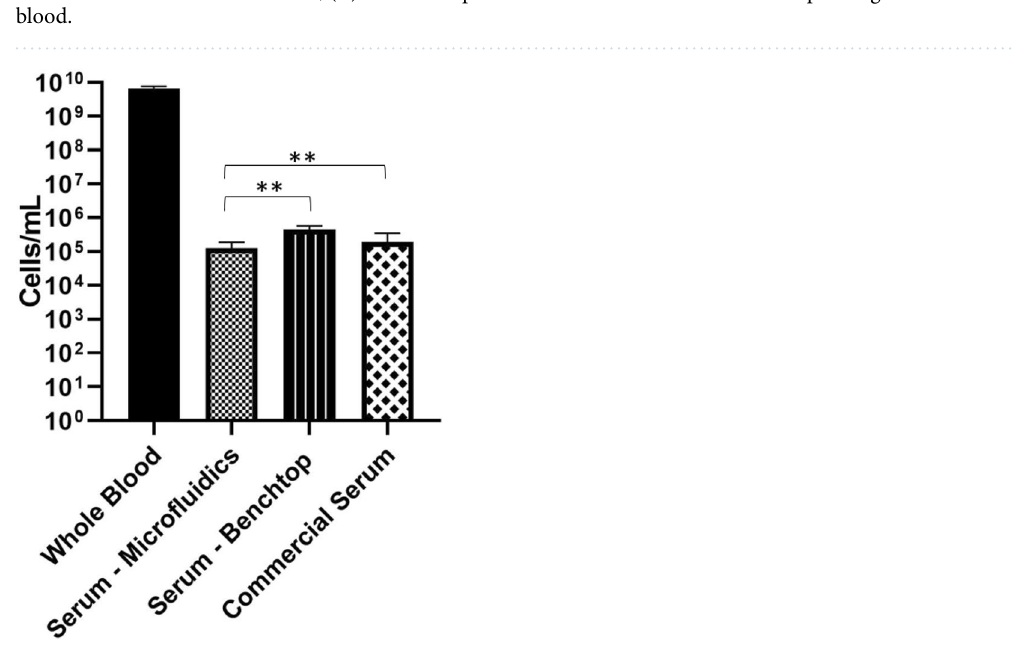
Figure 4. Average cell counts (n = 3) on whole blood (6.8 × 10 9 cells/mL), serum processed on the microfluidic device (1.27 × 10 5 cells/mL), serum processed by benchtop methods (4.45 × 10 5 cells/mL), and commercially- available serum (1.9 × 10 5 cells/mL). **Statistical